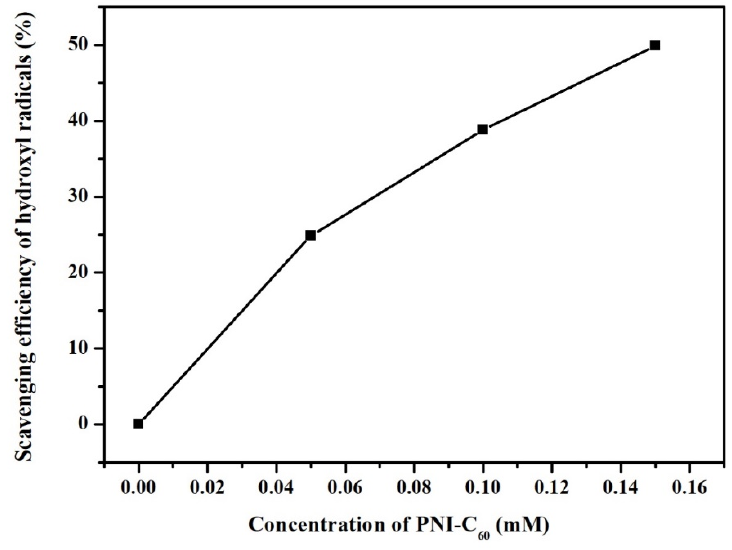
Figure 9. Hydroxyl radical scavenging efficiency of PNI-C 60 in Fenton reaction at different concentrations.